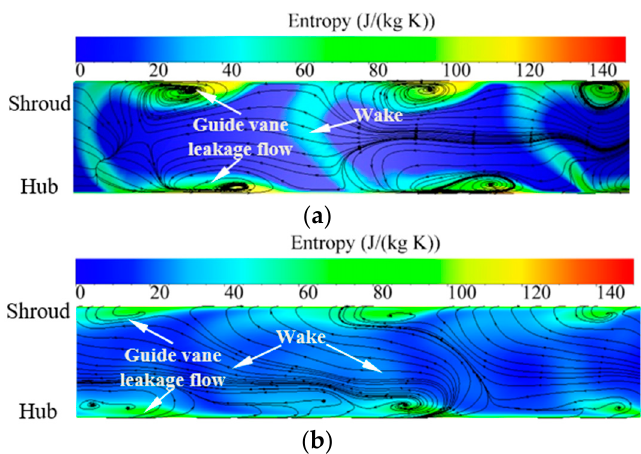
Figure 9. Streamline and loss distribution diagram at the rotor inlet of the two models: ( a ) streamline and loss of the base model; ( b ) streamline and loss of the SSGV model.